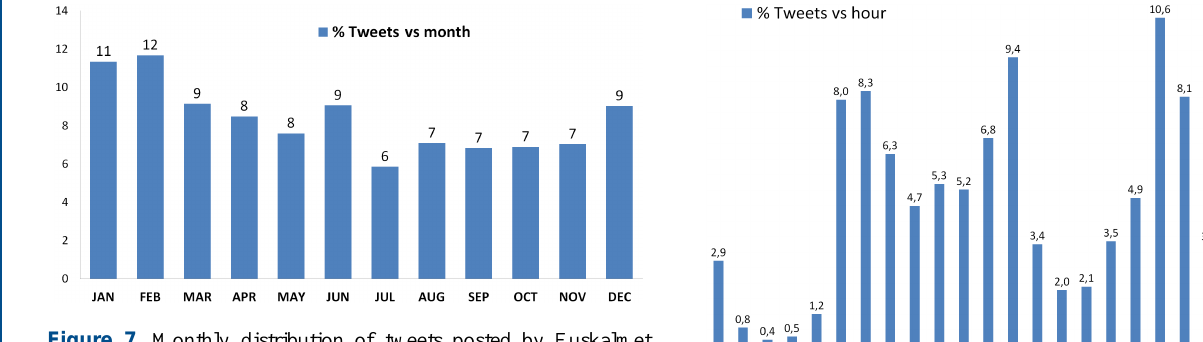
Figure 7. Monthly distribution of tweets posted by Euskalmet (from July 2011 to August 2014).